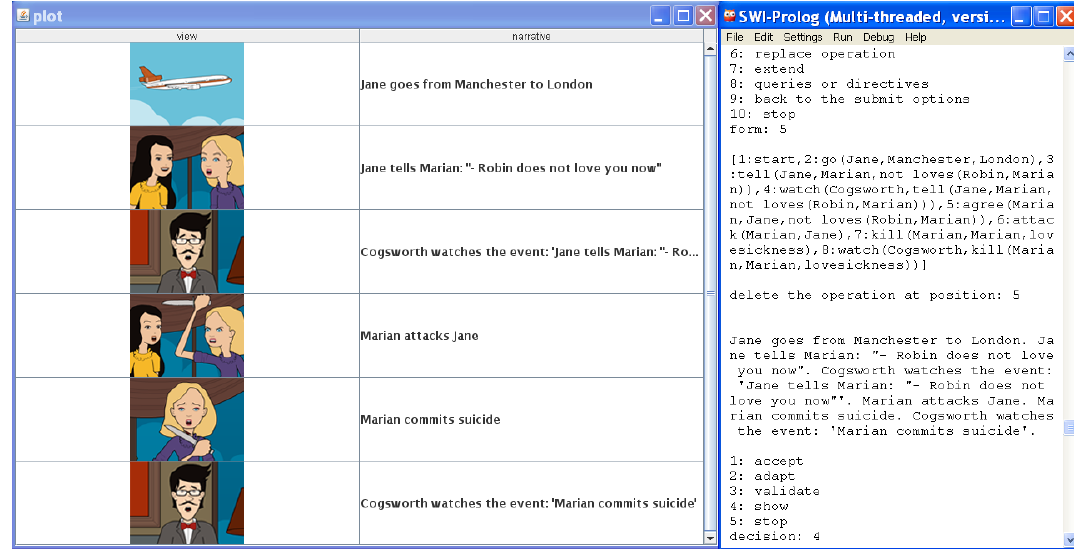
Fig. 2. Interactive composition with PlotBoard .